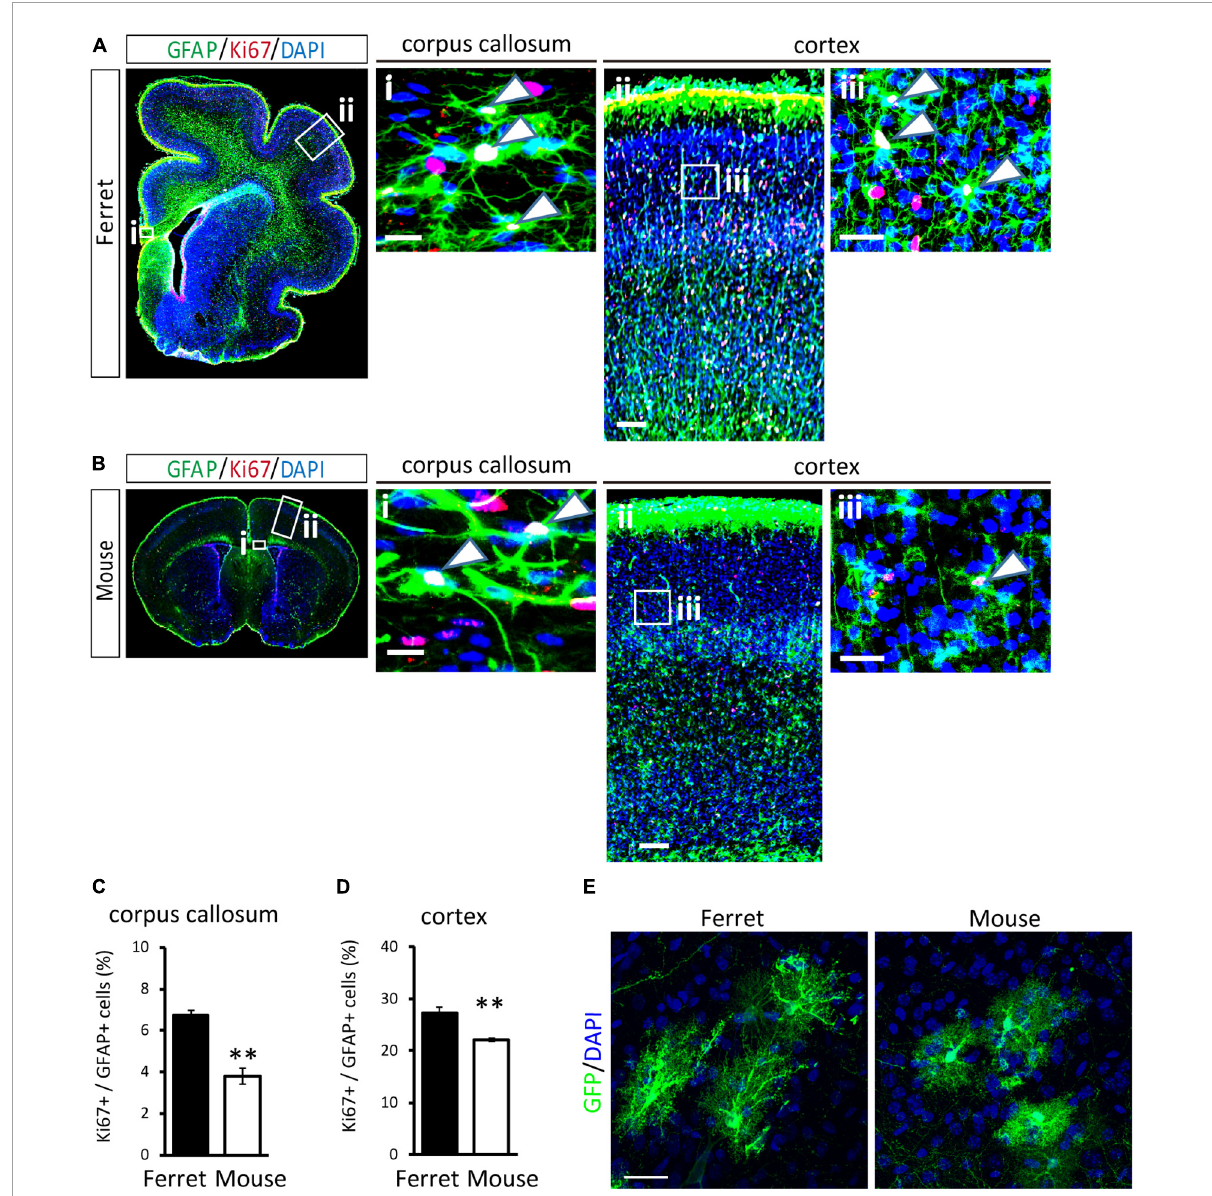
FIGURE5 Proliferation of ferret and mouse astrocytes in the developing brain. (A,B) Representative images of GFAP and Ki67 in the cortex and corpus callosum of the postnatal ferret at P16 (A) and mouse at P8 (B) . Nuclei were stained with DAPI. Arrowheads indicate Ki67-positive astrocytes. (C,D) Proportion of Ki67-positive cells in GFAP-expressing astrocytes in the corpus callosum (C) and cortex (D) of ferret and mouse brains. (E) Representative images of GFP-transfected astrocytes in the cortex of the ferret (P36) and mouse (P30). Scale bars = 100 µ m in (A i) and (B i) ; 200 µ m in (A ii) and (B ii) ; 50 µ m in (A iii) and (B iii) ; and 30 µ m in panel (E) . n = 4 animals each group. Data represent the means ± SEM. The P -values were determined using paired Student’s t -test. ∗∗ P <